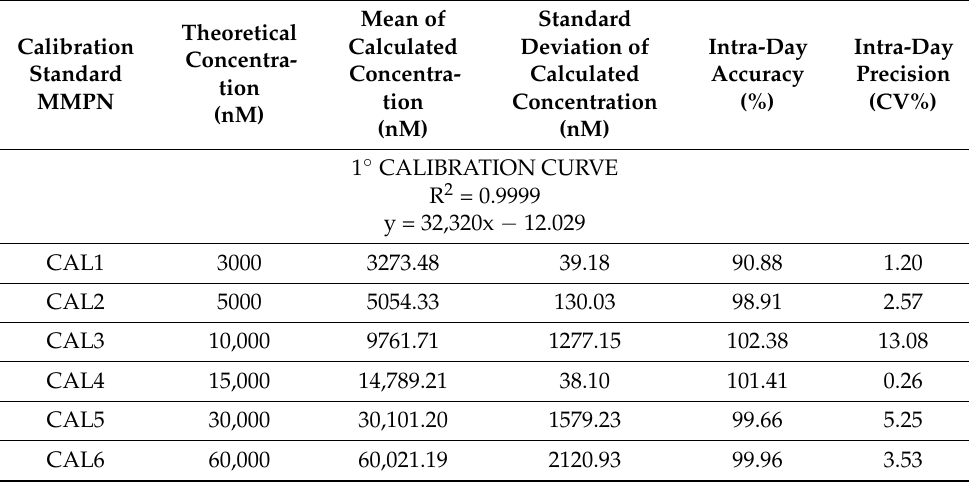
Table 3. Intra-day accuracy and precision (CV%) referred to CALs of